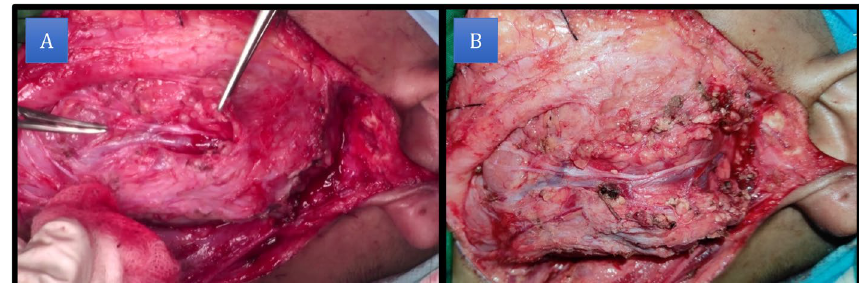
Fig. 4 Retrograde dissection of the facial